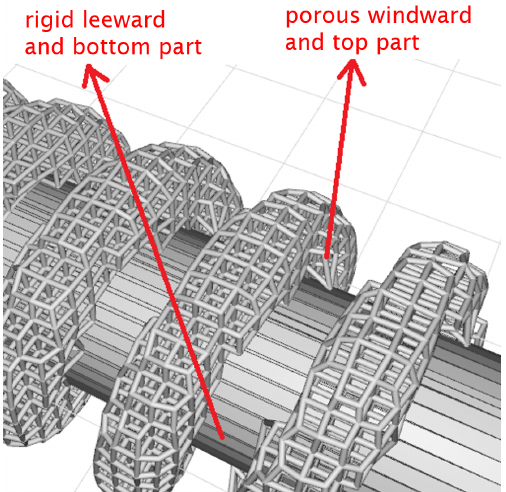
Figure 26. Porous and rigid part in the same vertical profile due to twisted design of the helical